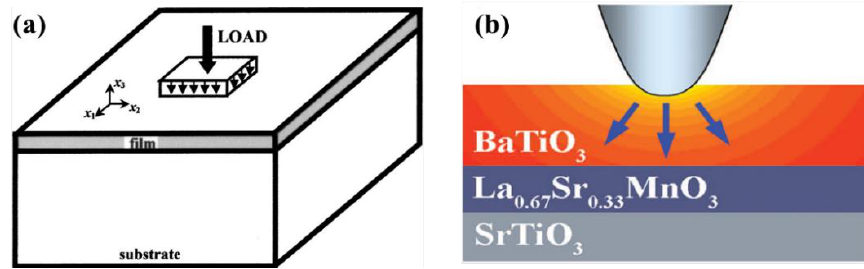
Figure 13. Schematic of ( a ) a uniform local loading (Reprinted with permission from [23]; Copyright 2002 by the American Physical Society) and ( b ) the strain gradient and associated flexoelectric field (arrows) induced by the atomic force microscopy (AFM) tip pushing on the surface of an ultrathin ferroelectric films (UFF). (Reprinted with permission from [329]; Copyright 2012 by AAAS).